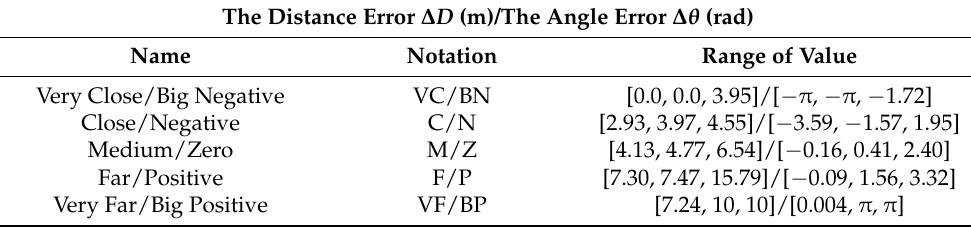
Table 10. The founded suboptimal parameters of the input membership